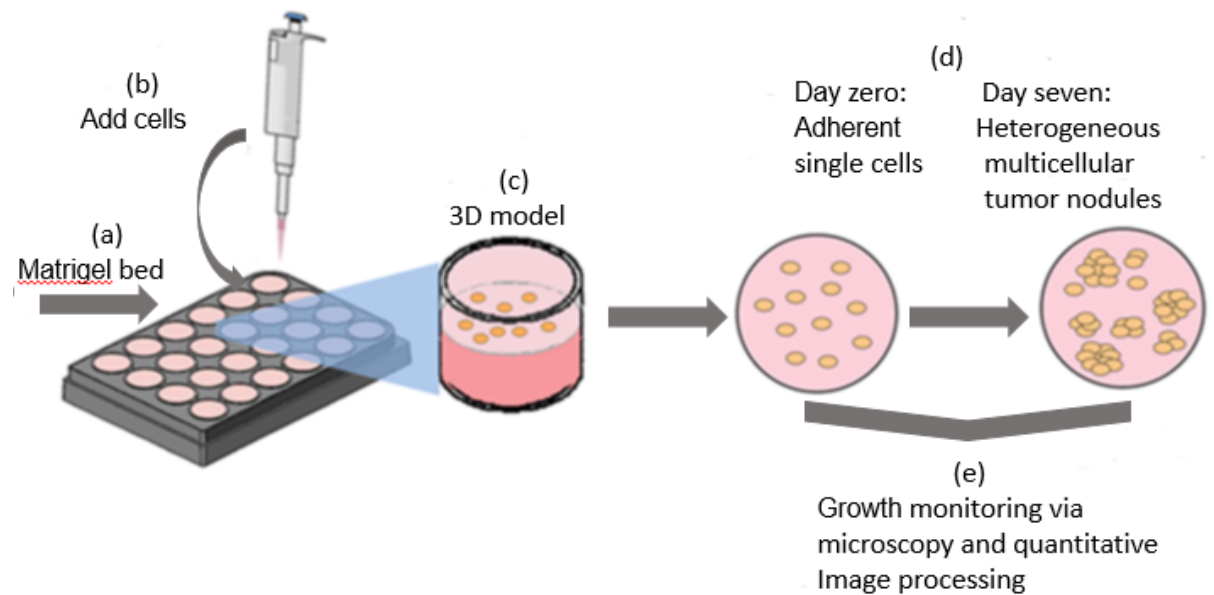
Figure 1. ( a – e ) The 3D cell culture model of A549 lung carcinoma cells: Cells were overlaid on ECM bed and allowed to grow for 7 days, leading to the formation of heterogeneous 3D tumor spheroids. Images were acquired longitudinally and analyzed to characterize growth behavior.